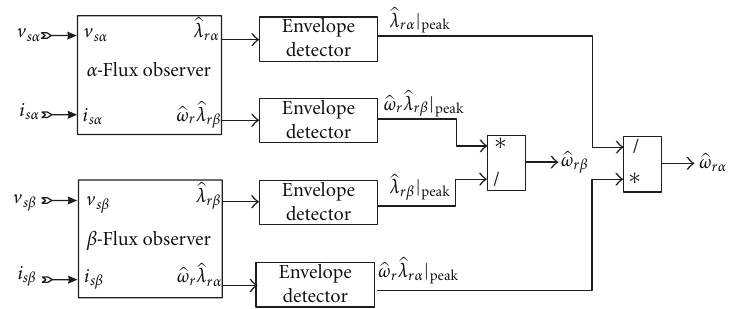
Figure 3: Speed estimation using flux observers and envelope detectors.